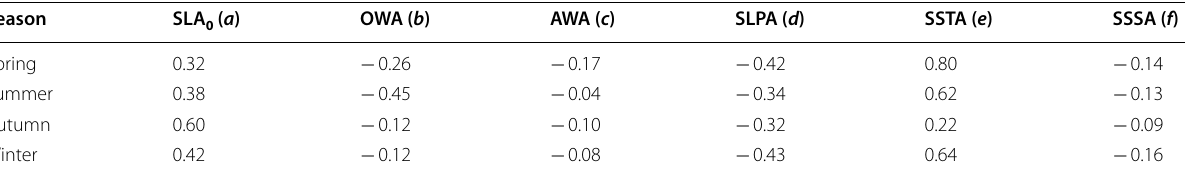
, OWA, AWA, SLPA, SSTA and SSSA north of the KE jet 0